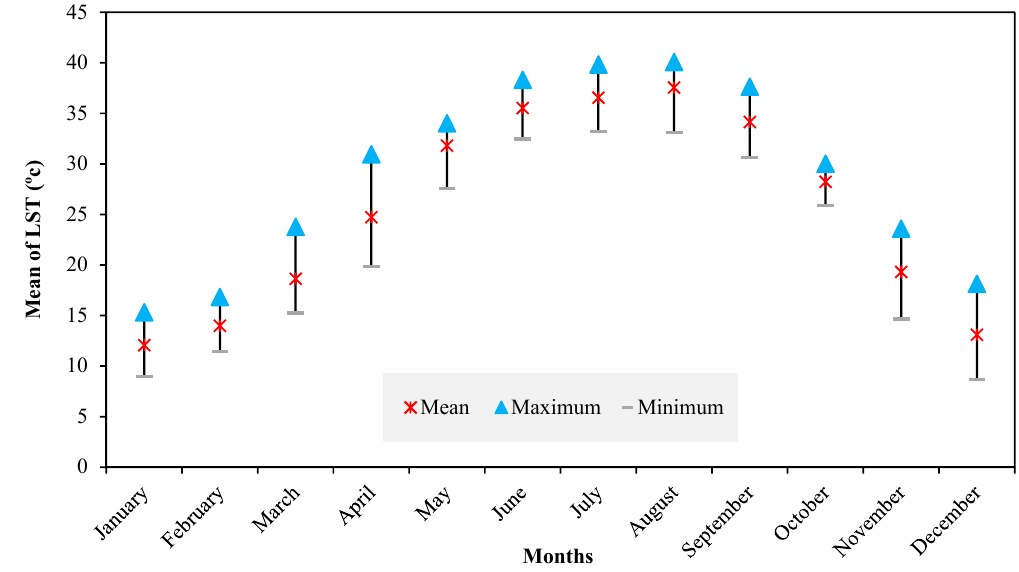
Figure 3. The LST mean for the study area obtained from MODIS products (MOD11C3) with 5000 m spatial resolution.